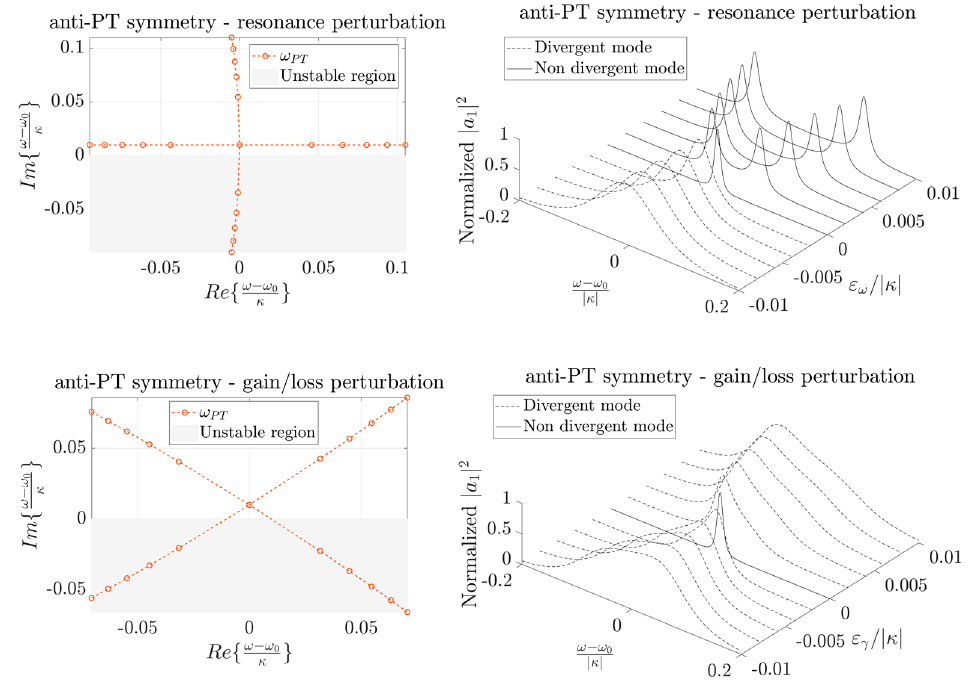
Figure 5. Eigenfrequency trajectories in the Gauss plane for PT-symmetric and anti-PT-symmetric systems ( left column ) due to perturbations of the resonance frequency or of the loss (gain) of one resonator: eigenfrequencies falling in the grey region (unstable region) causes instability. Normalized energy in one of the resonators ( right column ) of PT-symmetric and anti-PT-symmetric systems (considering inputs s in1 = 1 and s in2 = 0) as a function of the value of the perturbation of the resonance ( ε ω ), or of the loss (gain) ( ε γ ): solid lines represent stable transfer functions and dashed lines represent unstable transfer functions.